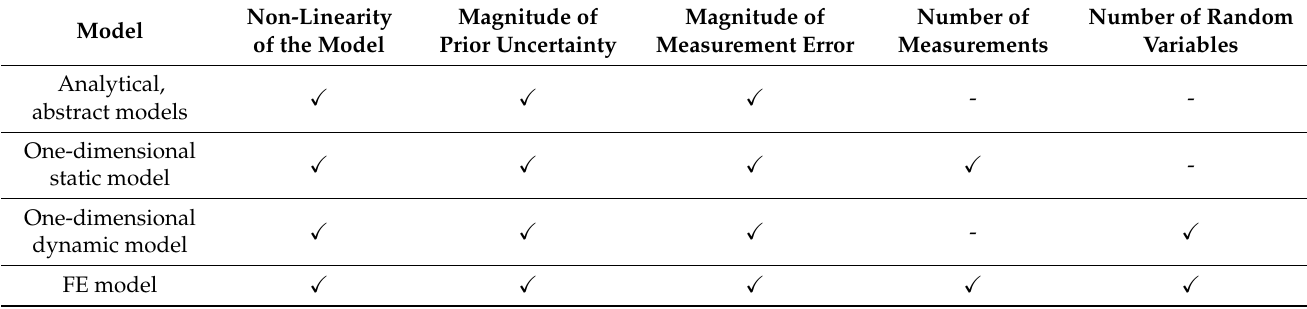
Table 1. Overview of the benchmark study: investigated issues and models